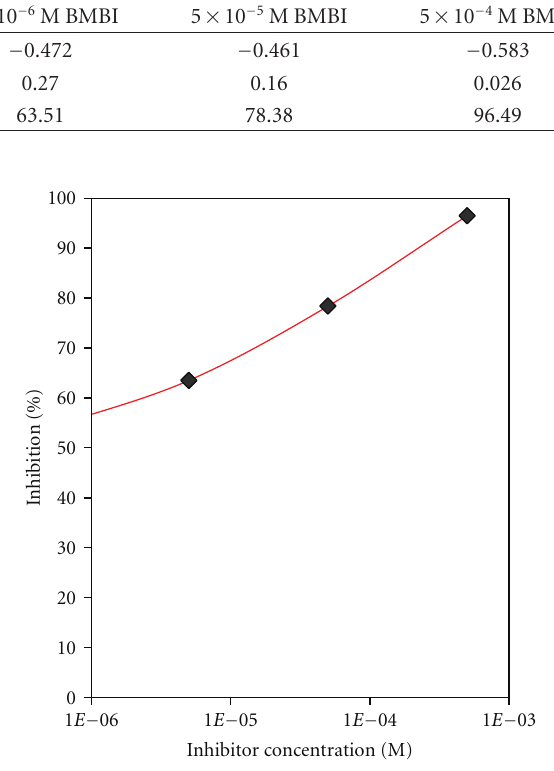
Figure 3: Percentage inhibition versus the concentration of 3- benzoylmethyl benzimidazolium hexafluoroantimonate (BMBI) at ambient